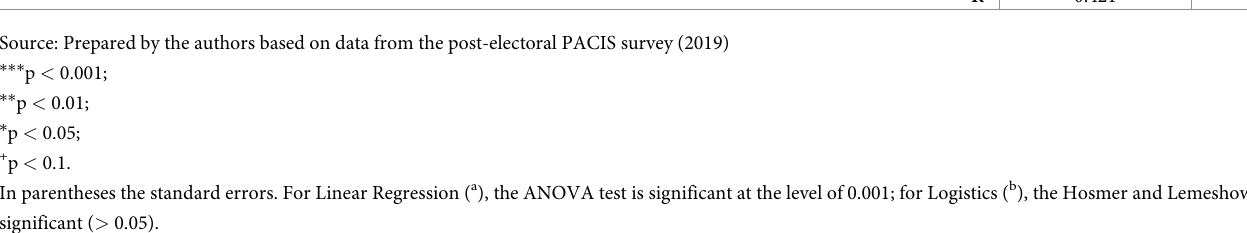
indicators underlying the same hypothesis (P3 for populism, P24 for immigration, P26 for feminism and P28 for authoritarianism). Including all independent variables in the models or exchanging the items included does not change the results obtained substantially (see Tables A9 and A11 in S1 File).